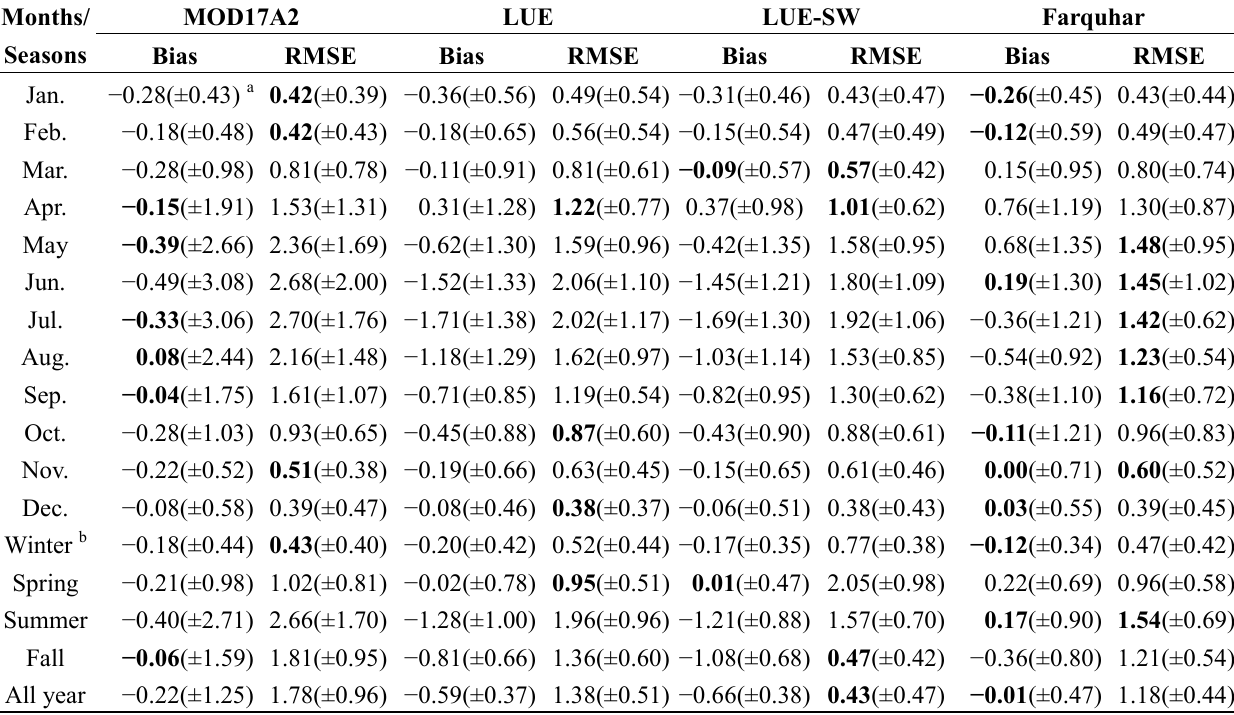
Table 3. Bias and root-mean-square error (RMSE) of daily GPP (in gC∙m −2 ∙day −1 ) with respect to individual months and seasons.